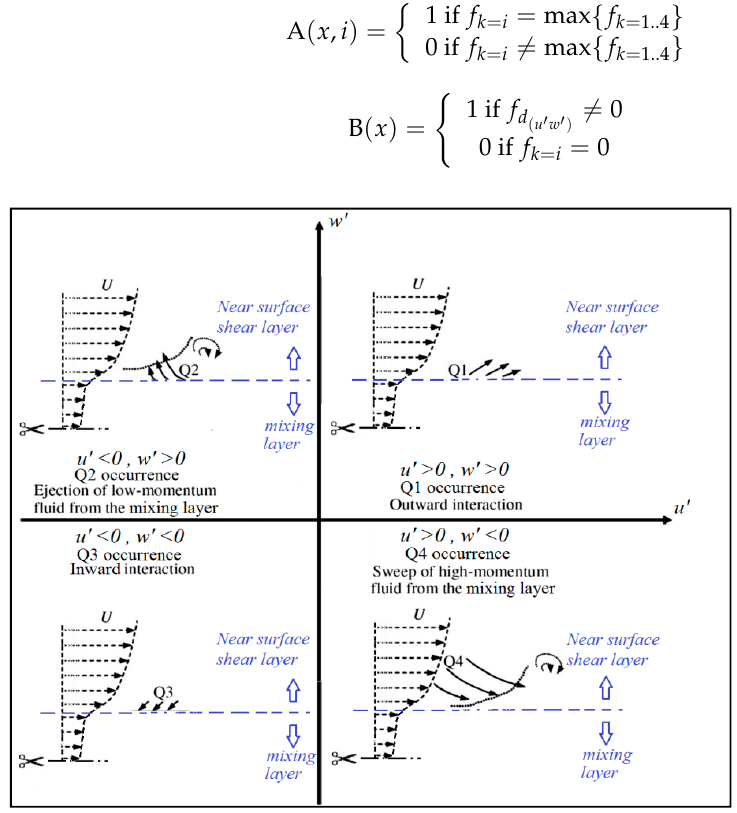
Figure 7. Conceptual illustration of the quadratic bursting events in the boundary between the mixing layer and the shear layer.